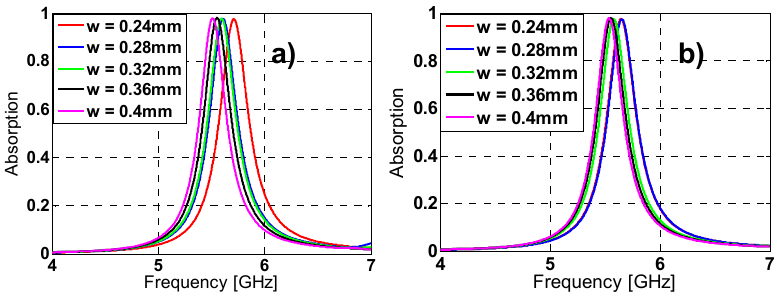
Figure 4. Absorption results in simulation for different lengths of w for both ( a ) TE ( b ) TM.